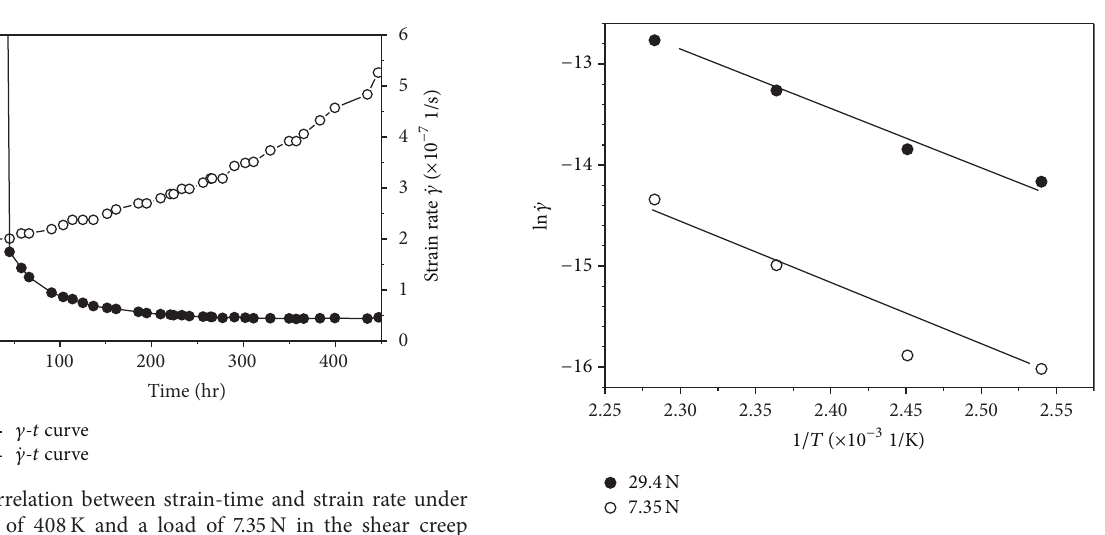
rateand thereciprocal of temperature intheshear creep